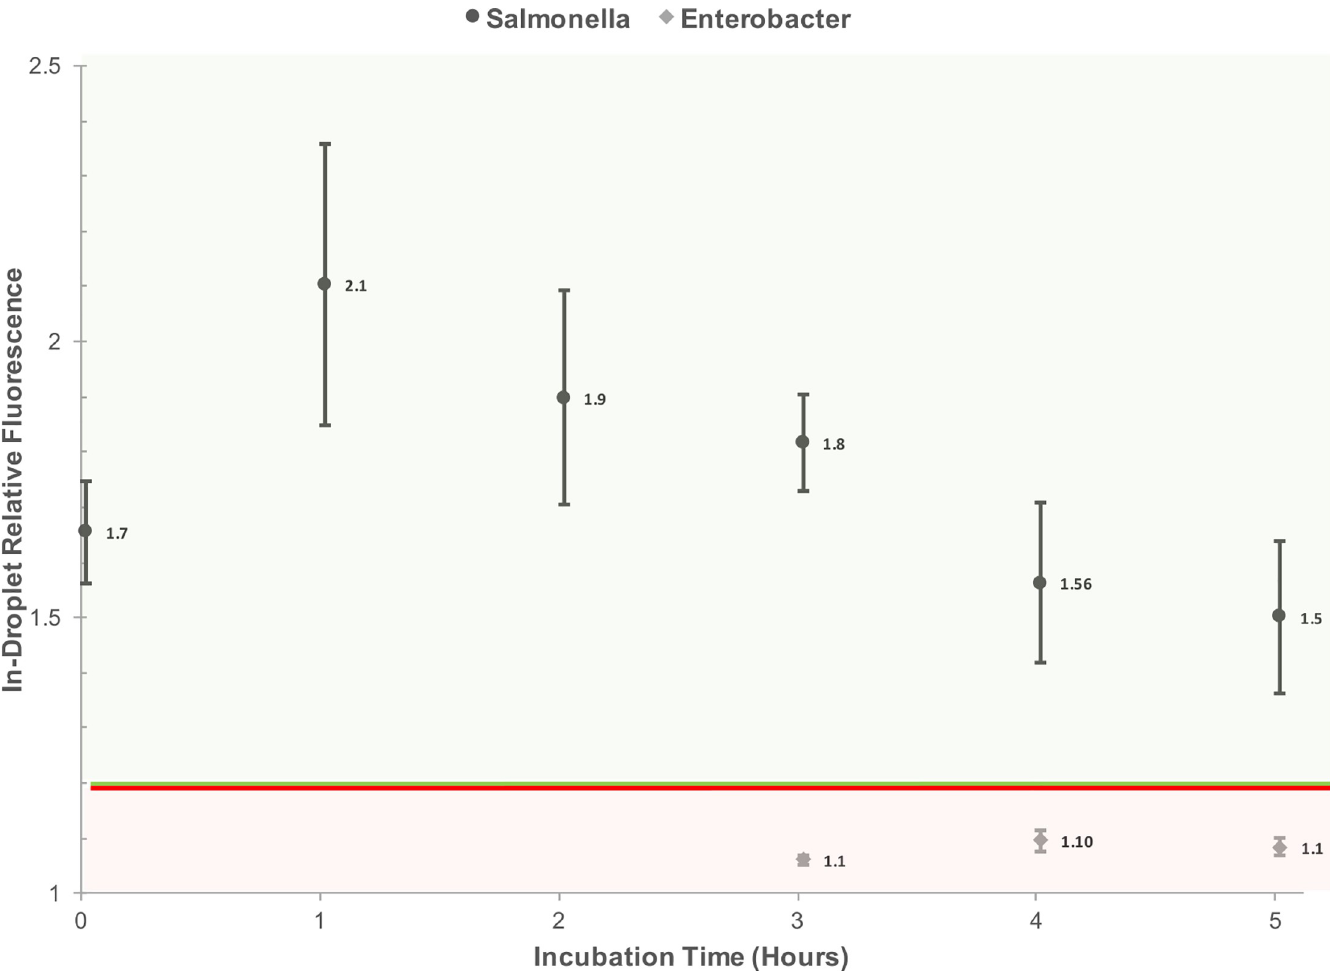
Fig 7. Relative fluorescence of encapsulated S . Typhimurium and E . aerogens in shredded lettuce wash water (0.5x in-droplet) and incubated in Rappaport- Vassiliadis broth (1x in-droplet) for 5 h with a FITC-Ab concentration of 10 μ g/ml in-droplet. A potential detection threshold region is identified on the figure. No measurable relative fluorescence was identified in time points 0 through 2 for both E . aerogens . Five replicates were measured for each bacterial species at each time